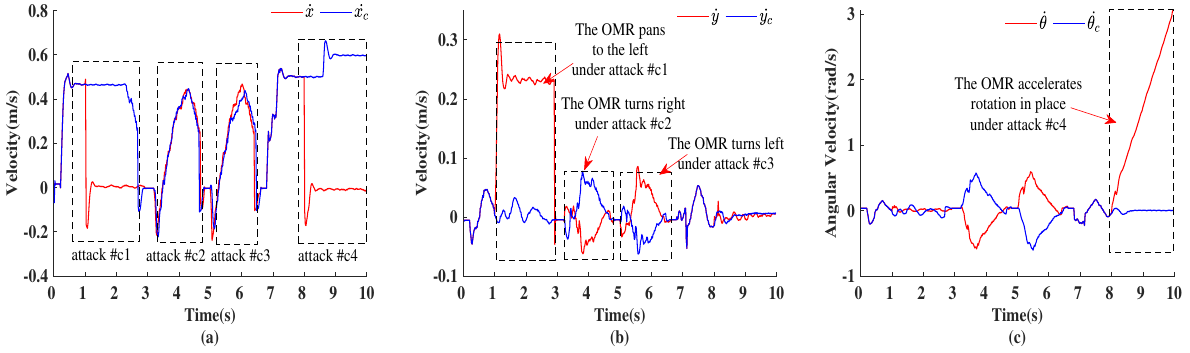
Figure 5. The situation when the OMR is subjected to covert attacks. ( a ) The real ˙ x of the OMR and the expected commands ˙ x c ; ( b ) the real ˙ y of the OMR and the expected commands ˙ y c ; ( c ) the real ˙ θ of the OMR and the expected commands ˙ θ c